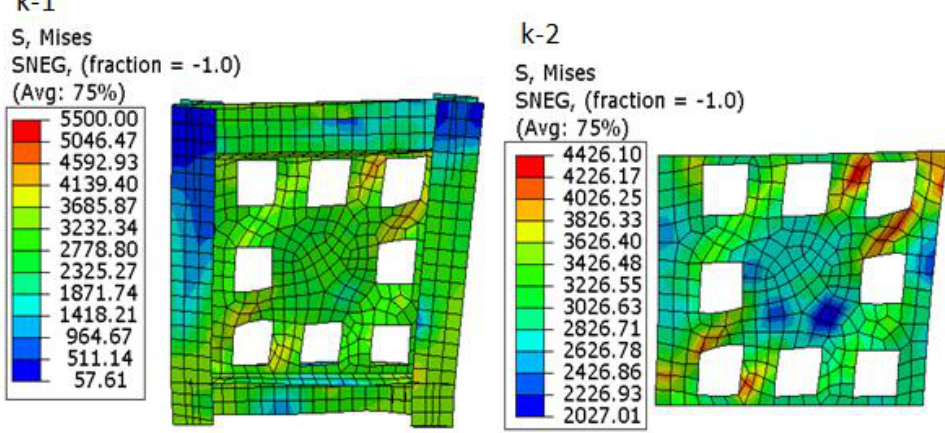
Figure 28. Von Mises stress for shell part (k-1) frame part and (k-2) steel plate.